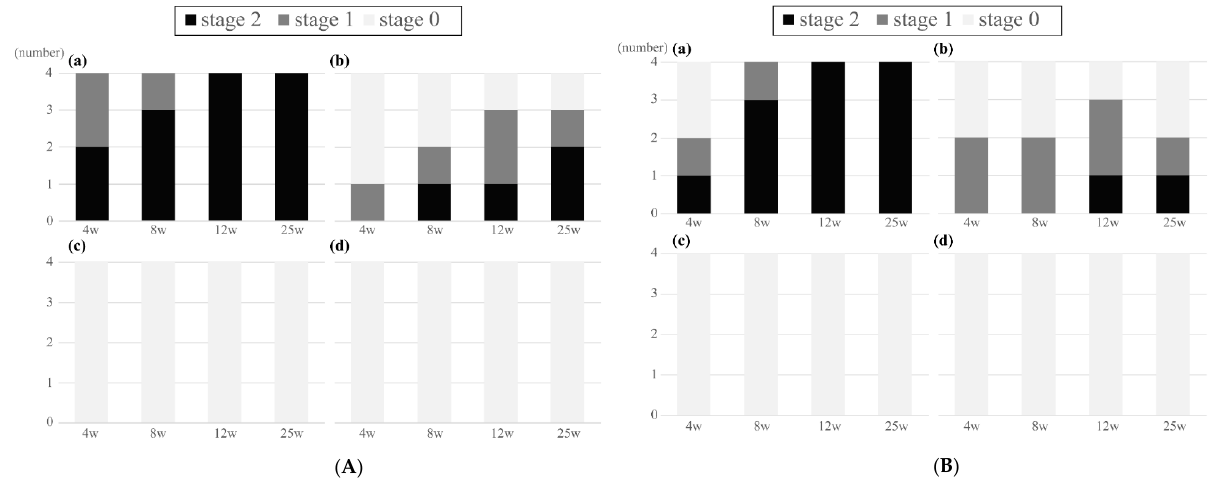
Figure 4. Radiological results of bone bridging above the threaded pins of ( A ) 2.0 mm and ( B ) 4.5 mm diameter. ( A ) Diameter: 2.0 mm. Depth: 1 (a) and 0 (b) mm. Protrusion: 1 (c) and 2 (d) mm. (a) Bone bridging was complete above all implants by 12 weeks. (b) At 25 weeks, two pins were completely covered by the new bone, and one had possible bone bridging. (c, d) Bone bridging was absent at all time points. ( B ) Diameter 4.5 mm. Depth: 1 (a) and 0 (b) mm. Protrusion: 1 (c) and 2 (d) mm. (a) Bone bridging was complete above all implants by 12 weeks. (b) Two had possible bone bridging at 4 and 8 weeks. At 12 weeks, one pin was completely covered by the new bone, and two had possible bone bridging. (c, d) Bone bridging was absent at all time